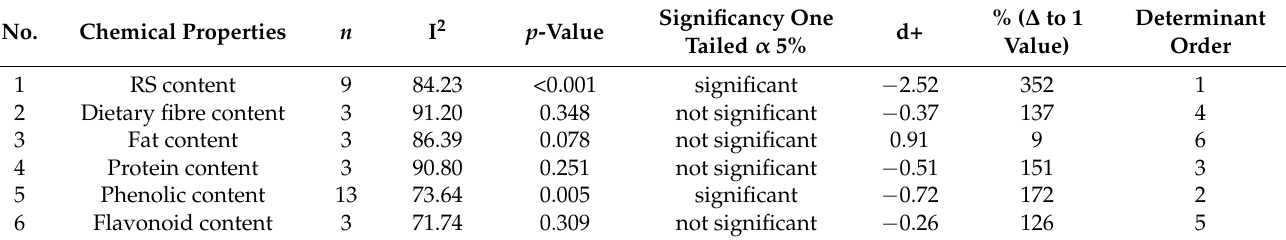
Table 4. Chemical properties of starchy foods determined to affect the GI in in vitro